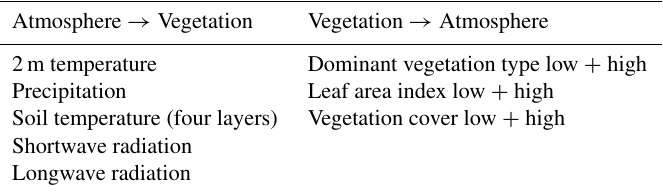
Table 5. Variables exchanged between the atmosphere and the vegetation model, with a coupling frequency of 1d (in standard and low resolution).